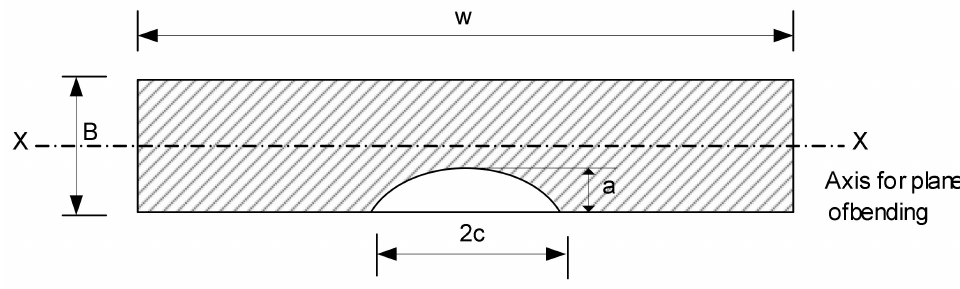
Figure 10. Flaw geometry for Zone III.